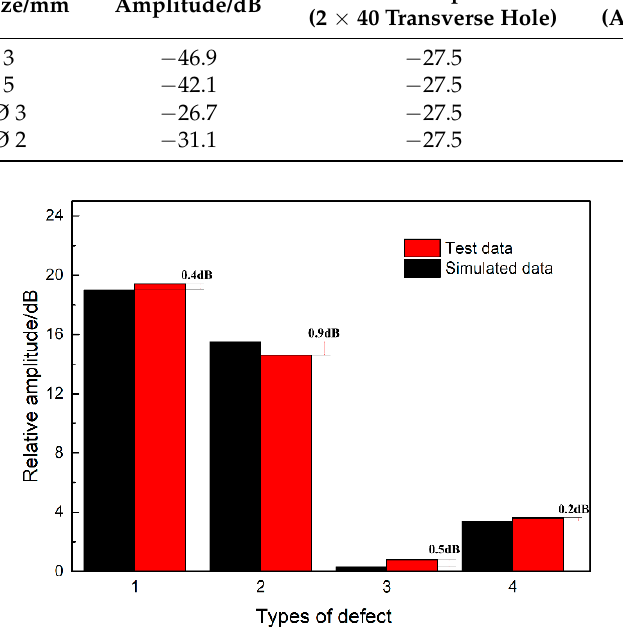
Figure 18. Comparison and analysis of test data and simulation data.